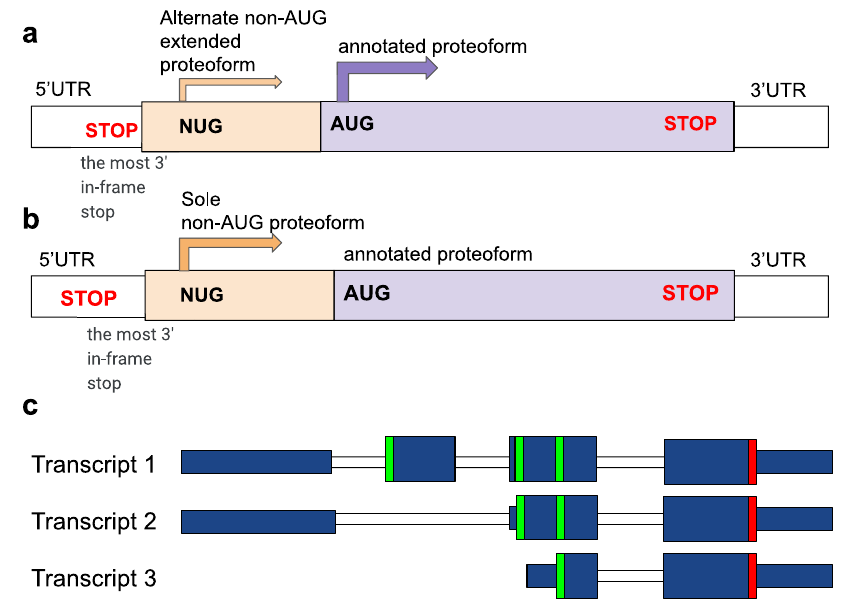
Fig.1|SourcesofalternativeN-termini.a Transcript with both major annotated proteoform and N-terminally extended non-AUG (NUG) initiated proteoform. b Transcript with sole non-AUG-initiated (NUG) proteoform. c Transcript 1 has an extra CDS exon relative to transcript 2, while transcript 3 has a different